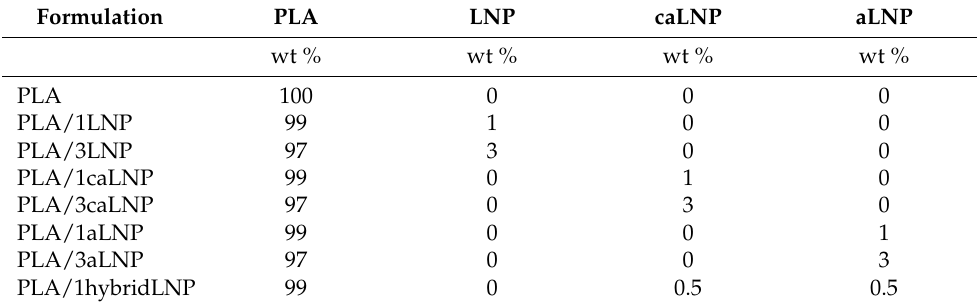
Table 1. PLA nanocomposites